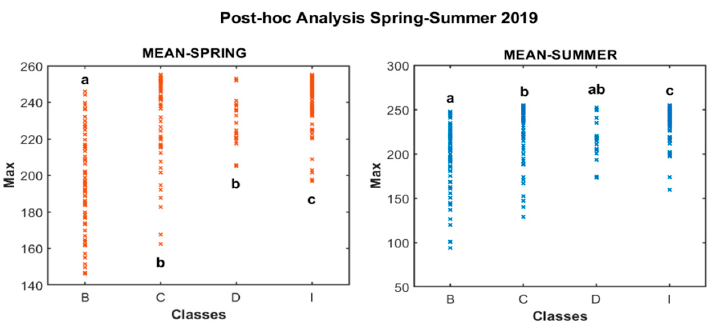
Figure 9. Post-hoc analysis for texture analysis (TA) showing the strength of association between the four major categorical classes (healthy broadleaves = B, healthy conifers = C, infested conifers = I, dead conifers = D) and the most significant descriptive statistic derived for the Mean variable in both seasons. Small letters (a,b,c,d) were used to denote significant differences between the groups ( p – value < 0.05).